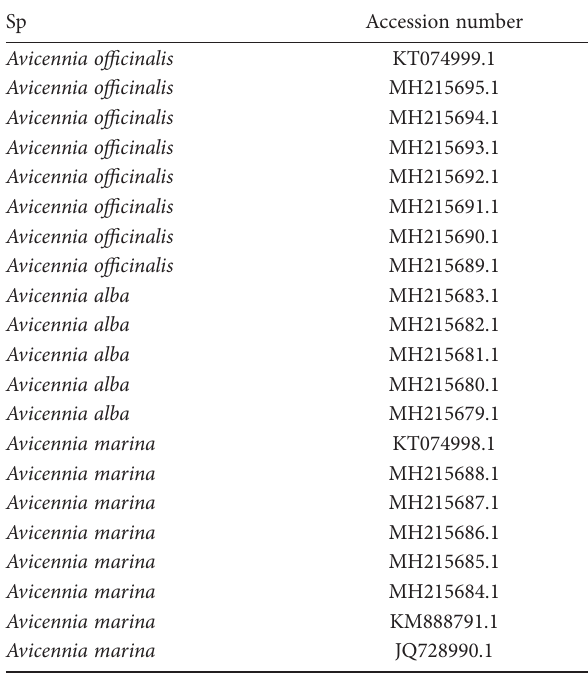
Table 1. Voucher information and GenBank accession numbers of taxa sampled for the genus Avicennia based on trnL-F